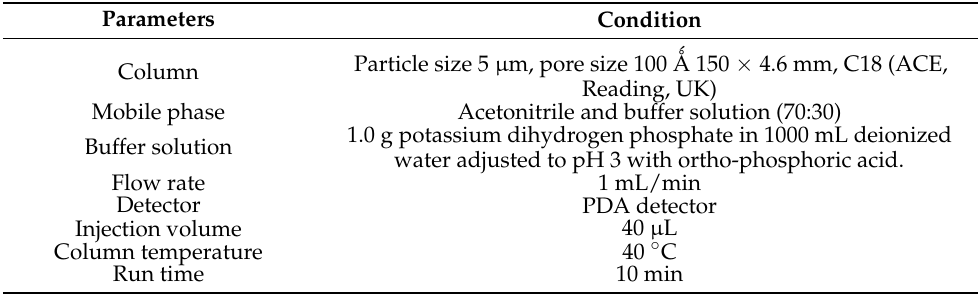
Table 2. HPLC operational conditions for the assay of salmeterol xinafoate and fluticasone propionate in a